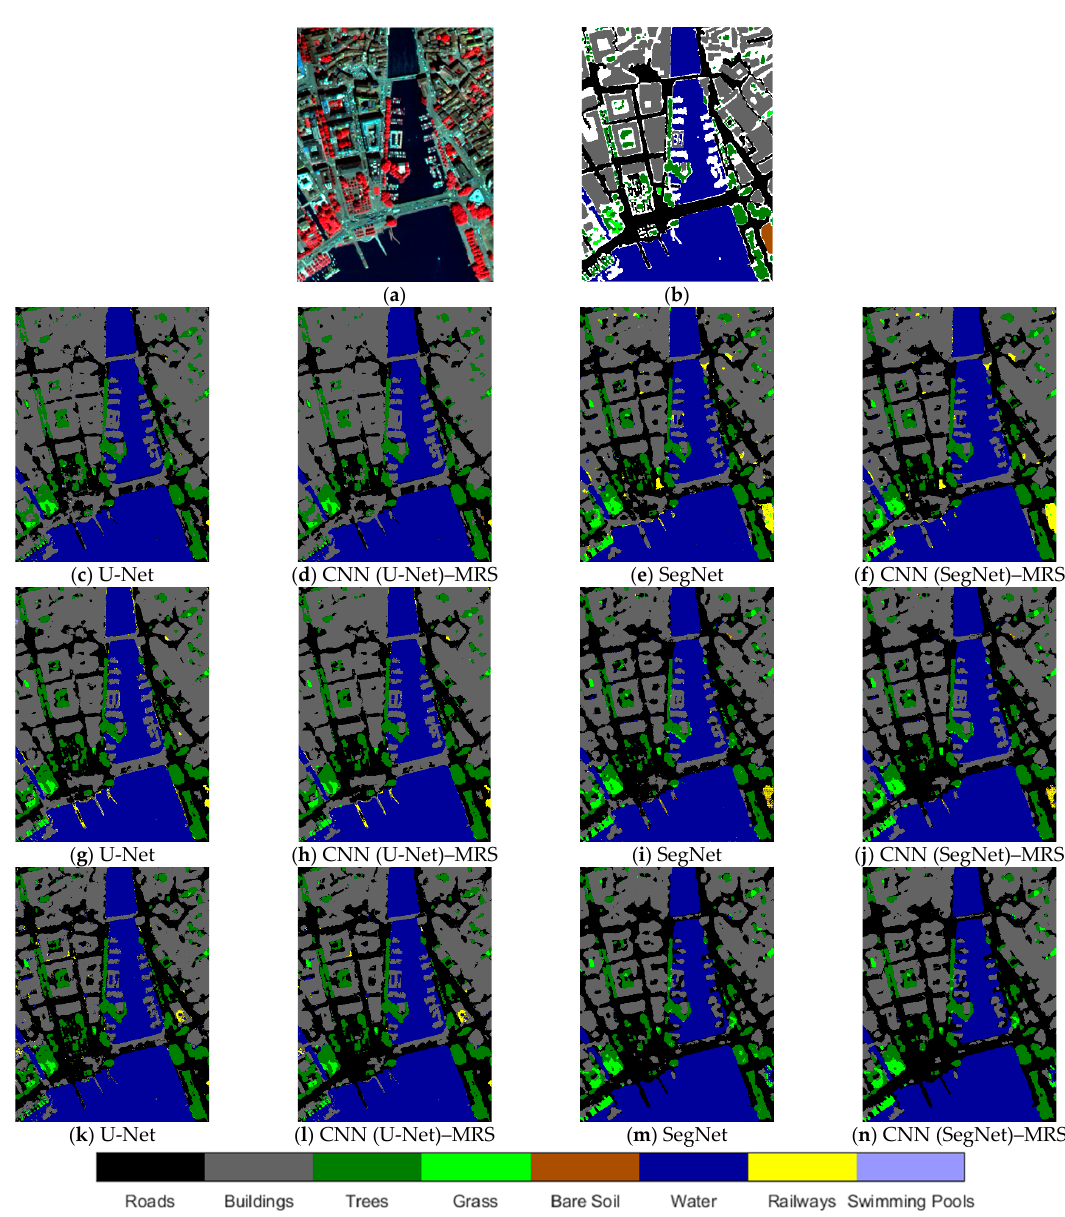
Figure 18. Results of Zurich dataset (ZH-16): ( a ) original image; ( b ) ground truth; ( c – f ) 32 × 32 patch size; ( g – j ) 64 × 64 patch size; ( k – n ) 128 × 128 patch size.